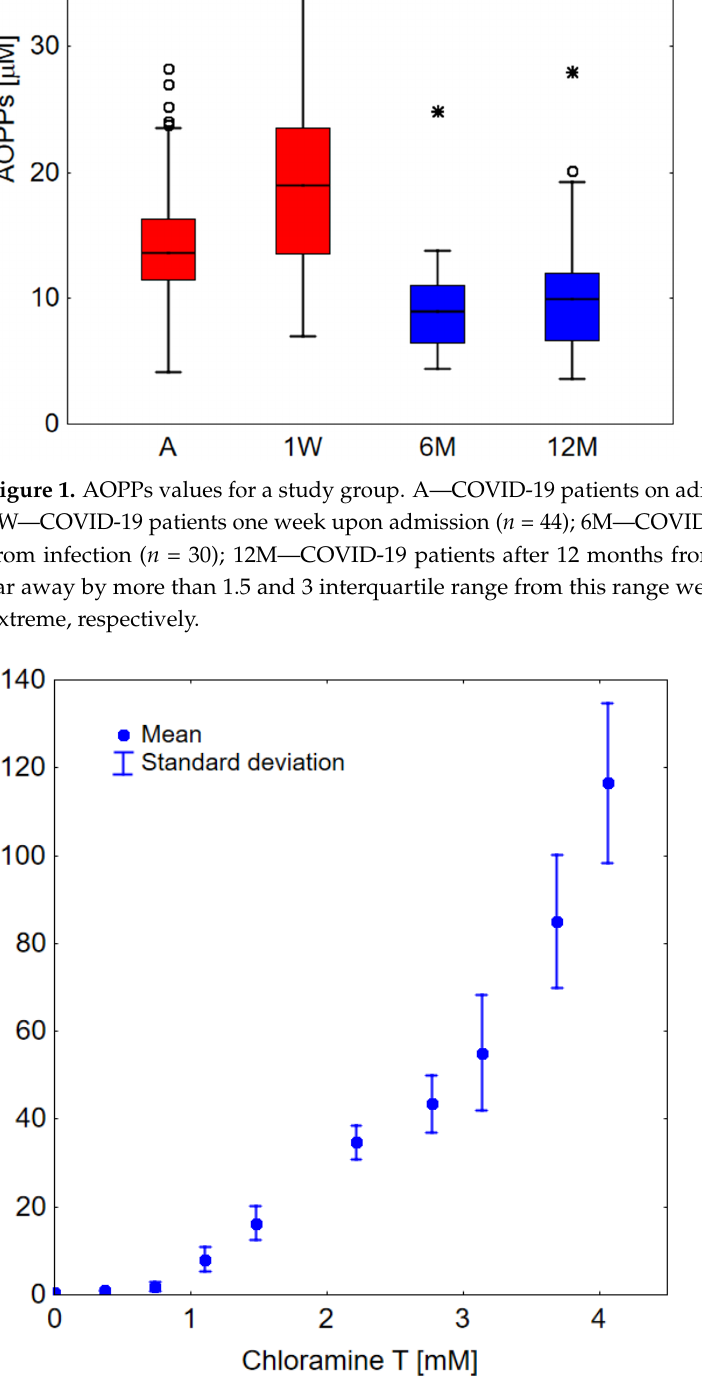
Figure 2. The formation of AOPPs dependence on chloramine T concentration added to HSA (100 µM). The measurements were repeated 3 times.